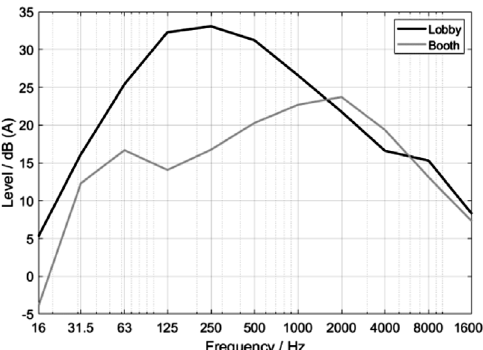
Figure 6. Boxplots of the SNR required to produce listening effort ratings of “ moderate effort ” , which is right in the middle of the listening effort